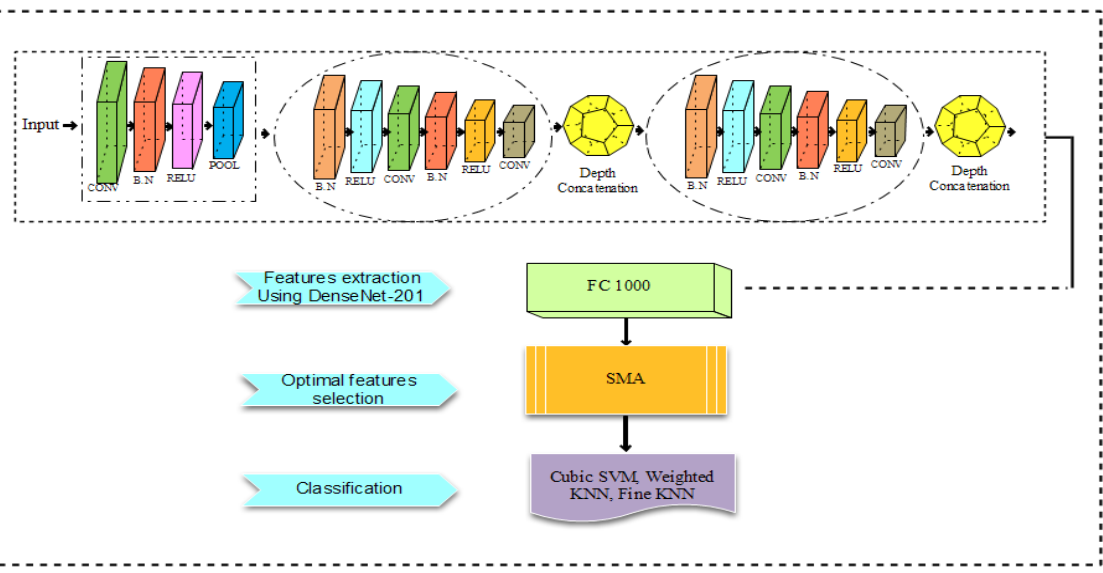
Table 2. Selected parameters of SMA. Features selection model